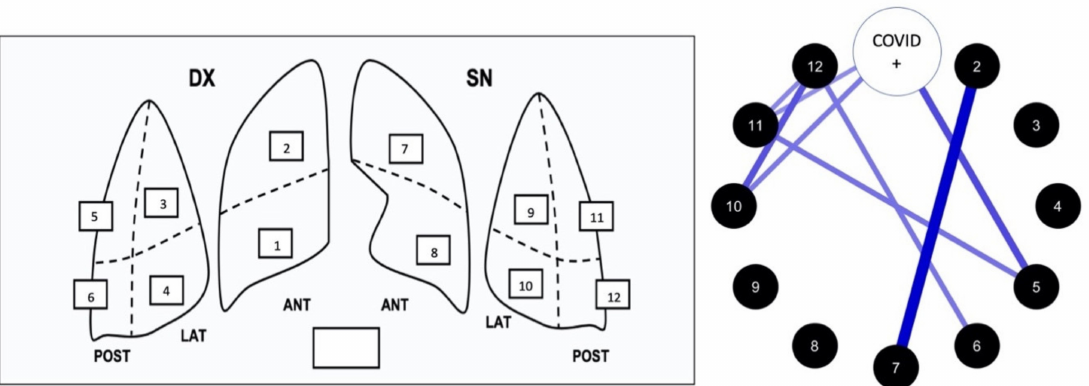
Figure 2. On the left : scheme of LUS score system of report with the 12 lung areas. Total lung score (0 to 48) is obtained from the sum of the score of each single lung area (0 to 4). On the right : correlation network analysis of the relationship between alterations of single area and COVID-19 positivity (see “Results” for more